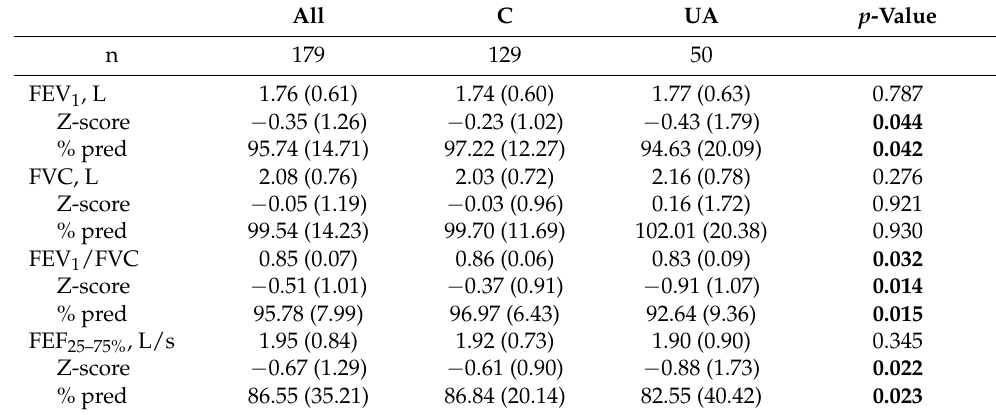
Table 2. Spirometry parameters by asthma